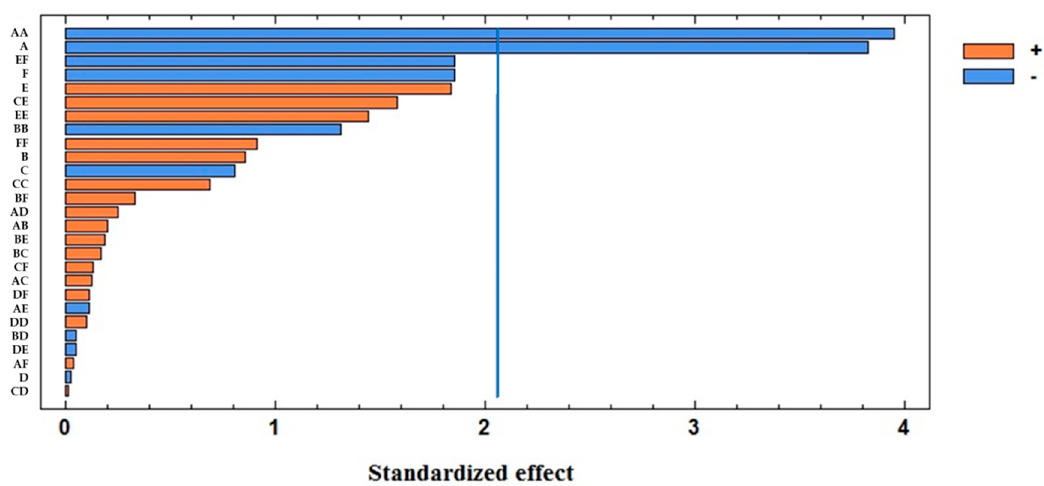
Figure 1. Standardized Pareto chart for TA extraction. A: Solvent (% MeOH); B: Temperature (°C); C: Amplitude (%); D: Cycle (s); E: pH; F: Ratio (mL).